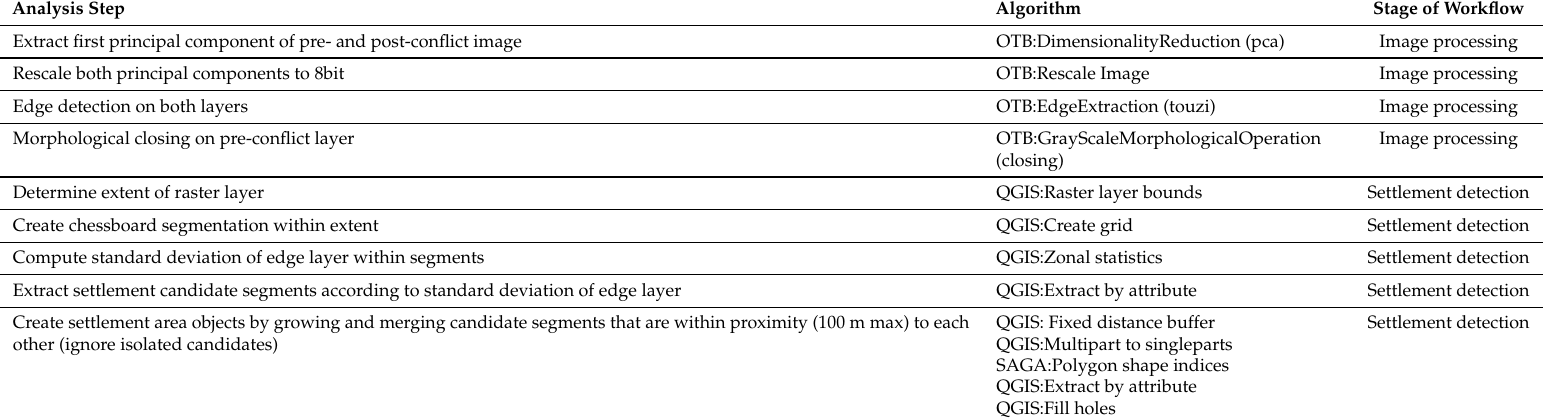
Table A2. Summary of the QGIS-based analysis workflow showing the processing steps and the corresponding algorithms (Python: the scripts written in Python; see Section